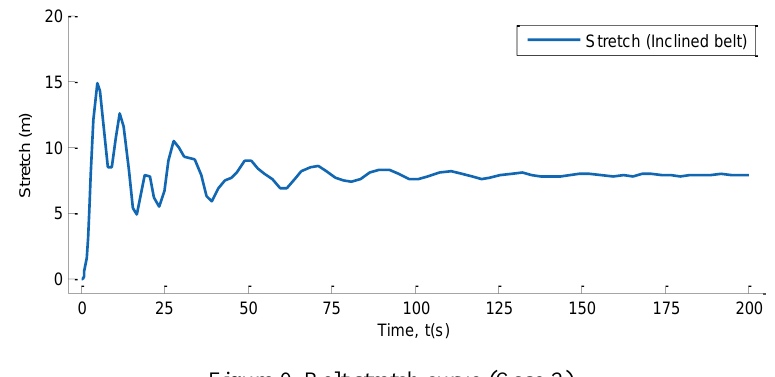
Figure 9. Belt stretch curve (Case